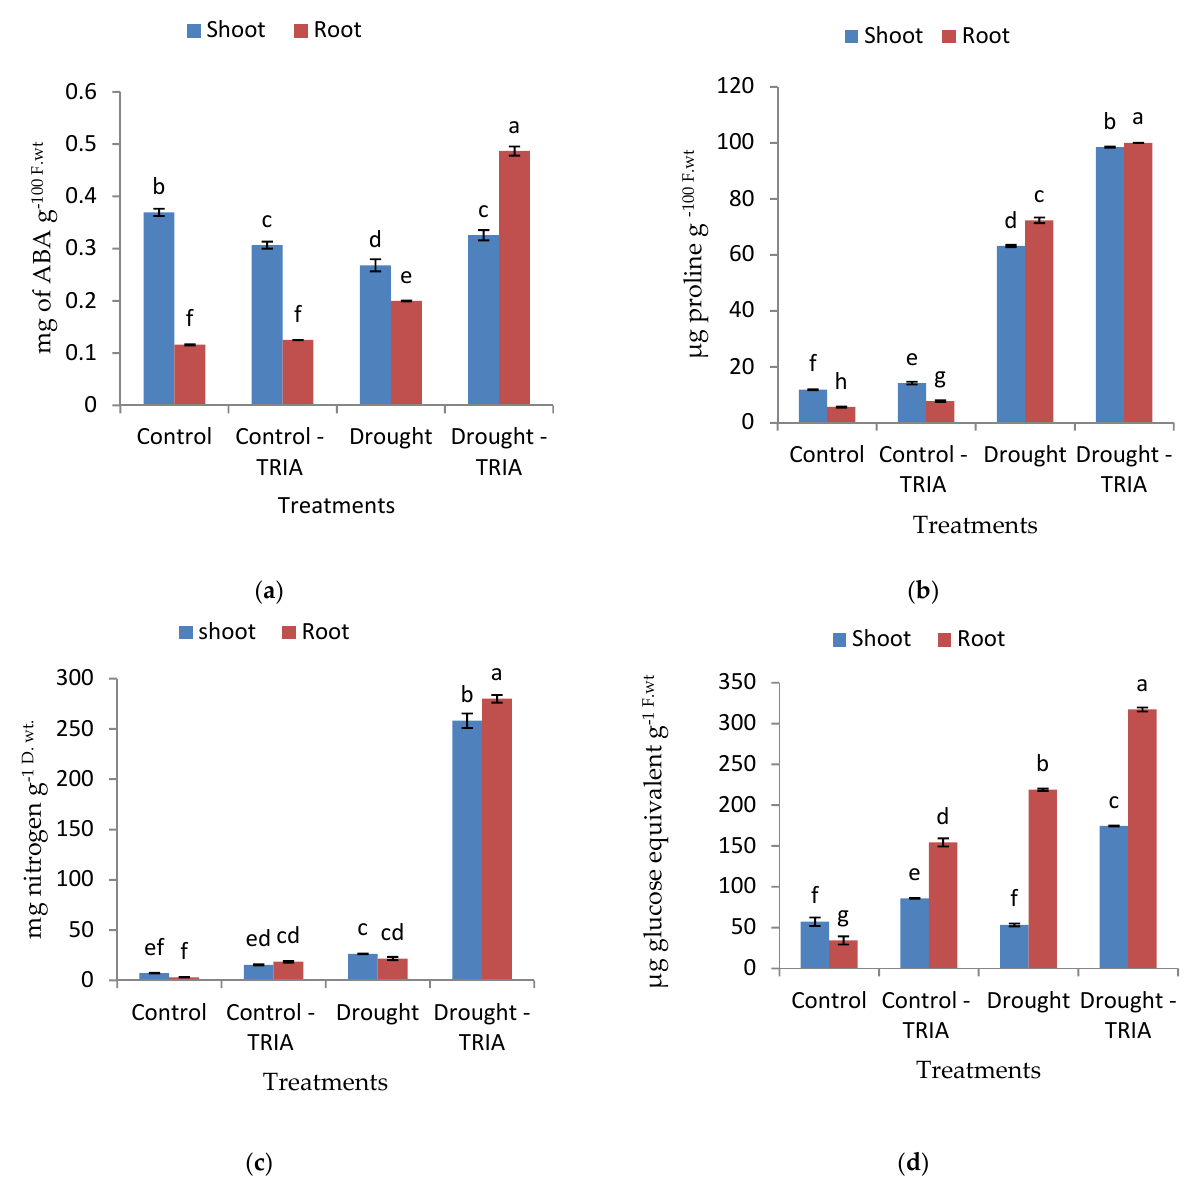
Figure 3. Effects of TRIA (35 ppm) treatment on ( a ) abscisic acid, ( b ) free proline, ( c ) free amino acids, and ( d ) total soluble sugars of drought-stressed rice seedlings. Each value is the mean of three replicates ± SE. Columns with different letters are significantly different at p ≤ 0.05.